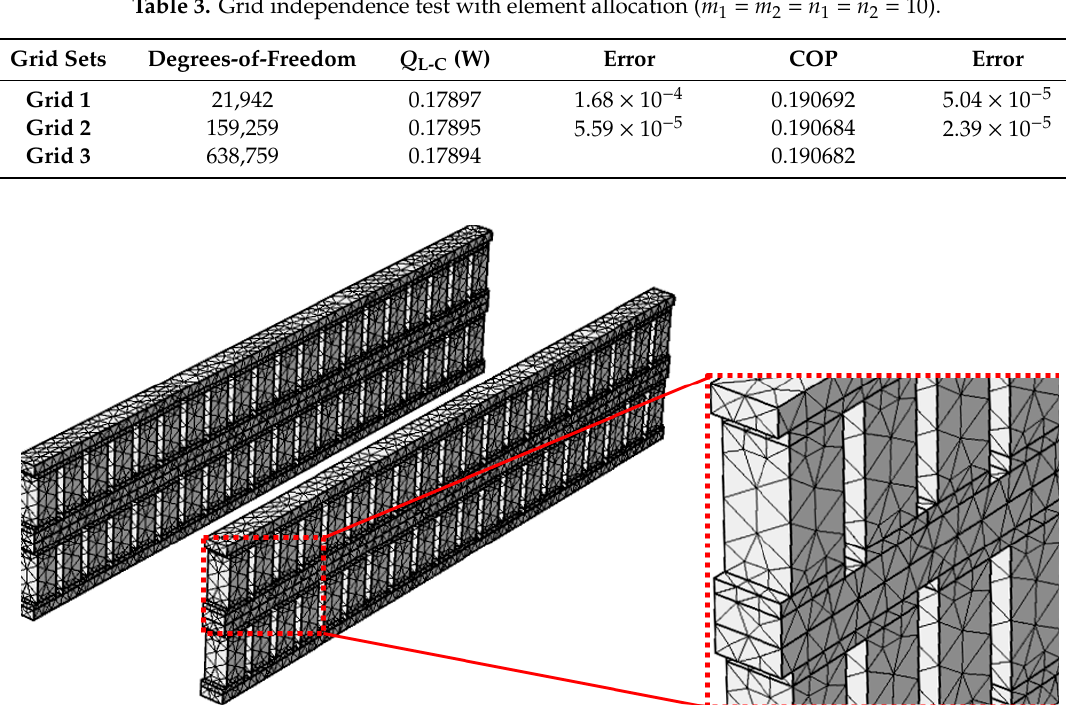
Figure 5. The characteristics of the grid used is the simulation.